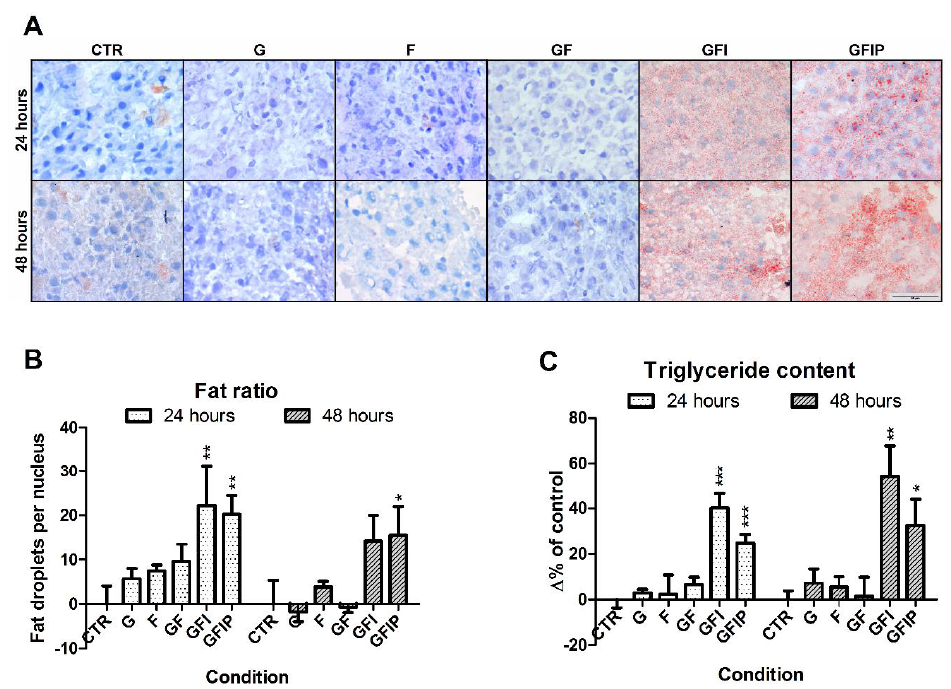
Figure 2. ( A ) Representative Oil Red O stained PCLS sections, cultured in different culture media, for 24 h and 48 h. CTR = control, G = Glucose, F = Fructose, GF = Glucose and fructose, GFI = Glucose, fructose, and insulin, GFIP = Glucose, fructose, insulin, and palmitic acid. ( B ) Fat-to-nucleus ratio. Oil Red O stained sections were used to determine the ratio of fat droplets per nucleus. Data is shown as the mean change in percentage of the ratio ± SEM ( N = 4). ( C ) Difference in measured triglyceride content after 24 h and 48 h. Data is expressed as mean difference in percentages of the 24 h untreated control ± SEM ( n = 5–6). Significance was determined using a one-way ANOVA, comparing all conditions from a time point to the control of that time point. * = p -value < 0.05, ** = p -value < 0.01, *** = p -value < 0.001.